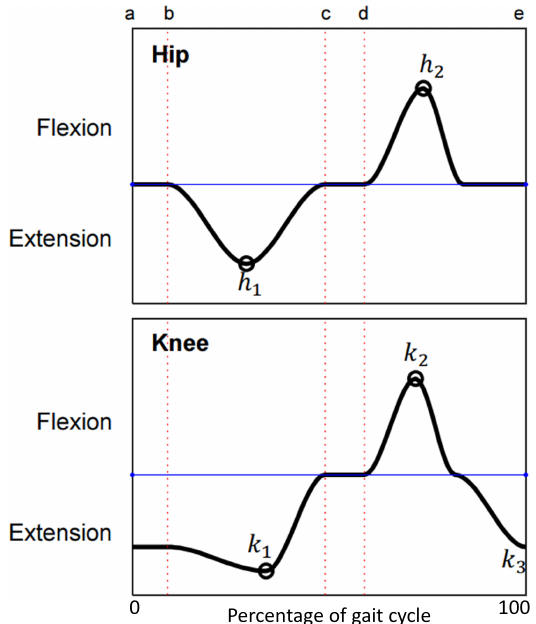
Figure 8. Assistive torque profile functions of hip and knee joints during a gait cycle: ( a ) the initial contact event of a leg, ( b ) the opposite foot-off event, ( c ) the initial contact of the opposite leg, ( d ) the foot-off (i.e., initial swing) event, and ( e ) the end of the gait (i.e., initial contact event of the next step). The amplitudes of the peak torque can be adjusted depends on the patient’s muscular strengths of each leg and desired assistance level. Based on the moments on normal gait with healthy people [25,26], the peak moments for normal walking can be assumed as − 0.5 and 1.2 Nm/kg for h − 0.65, 0.2, and − 0.5 Nm/kg for k 1 and h 2 , respectively, and 1 , k 2 , and k 3 ,